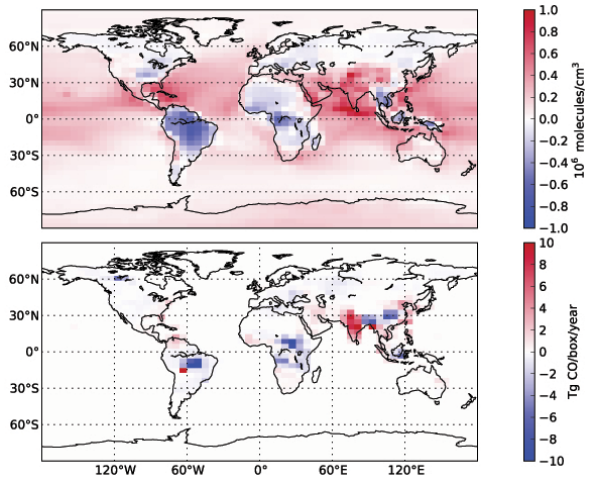
Fig. 8. Top: vertically integrated mass- and rate constant weighted OH difference field (TM5 – Spivakovsky et al., 2000). Bottom: emission increments difference for 2004, OH – Base. Reddish col- ors indicate higher OH levels in the TM5 OH field compared to the OH field from Spivakovsky et al. (2000) (top) and increased emis- sions with respect to the base inversion (bottom). Blueish colors indicate lower OH levels (top) and decreasing emissions